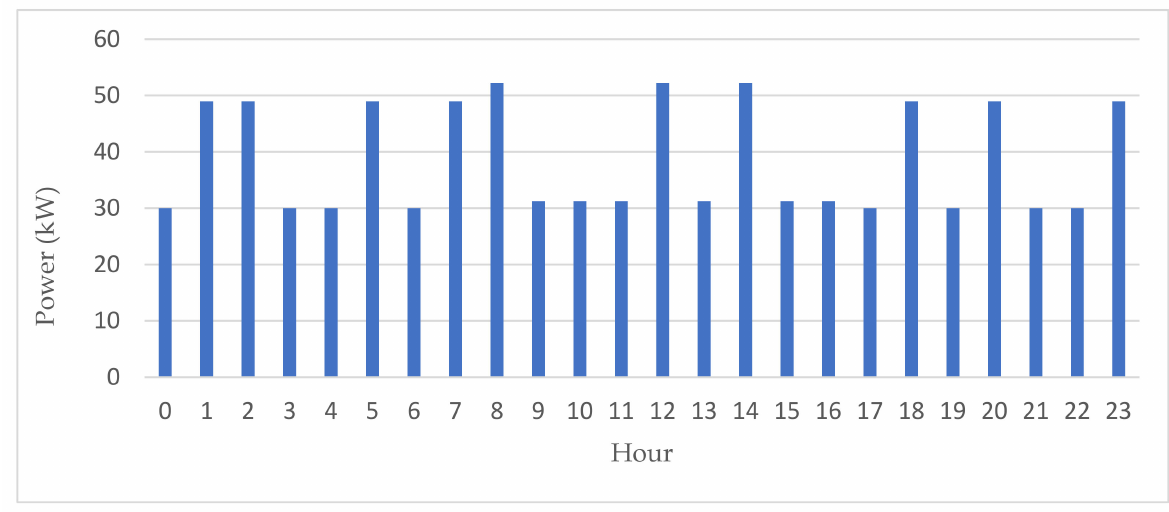
Figure 6. Cold Storage Daily Load Profile.